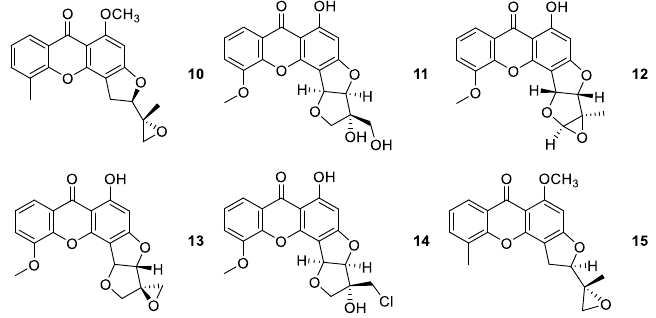
Figure 2. Structures of psorospermin ( 10 ) and synthetic derivatives 11 – 15 .